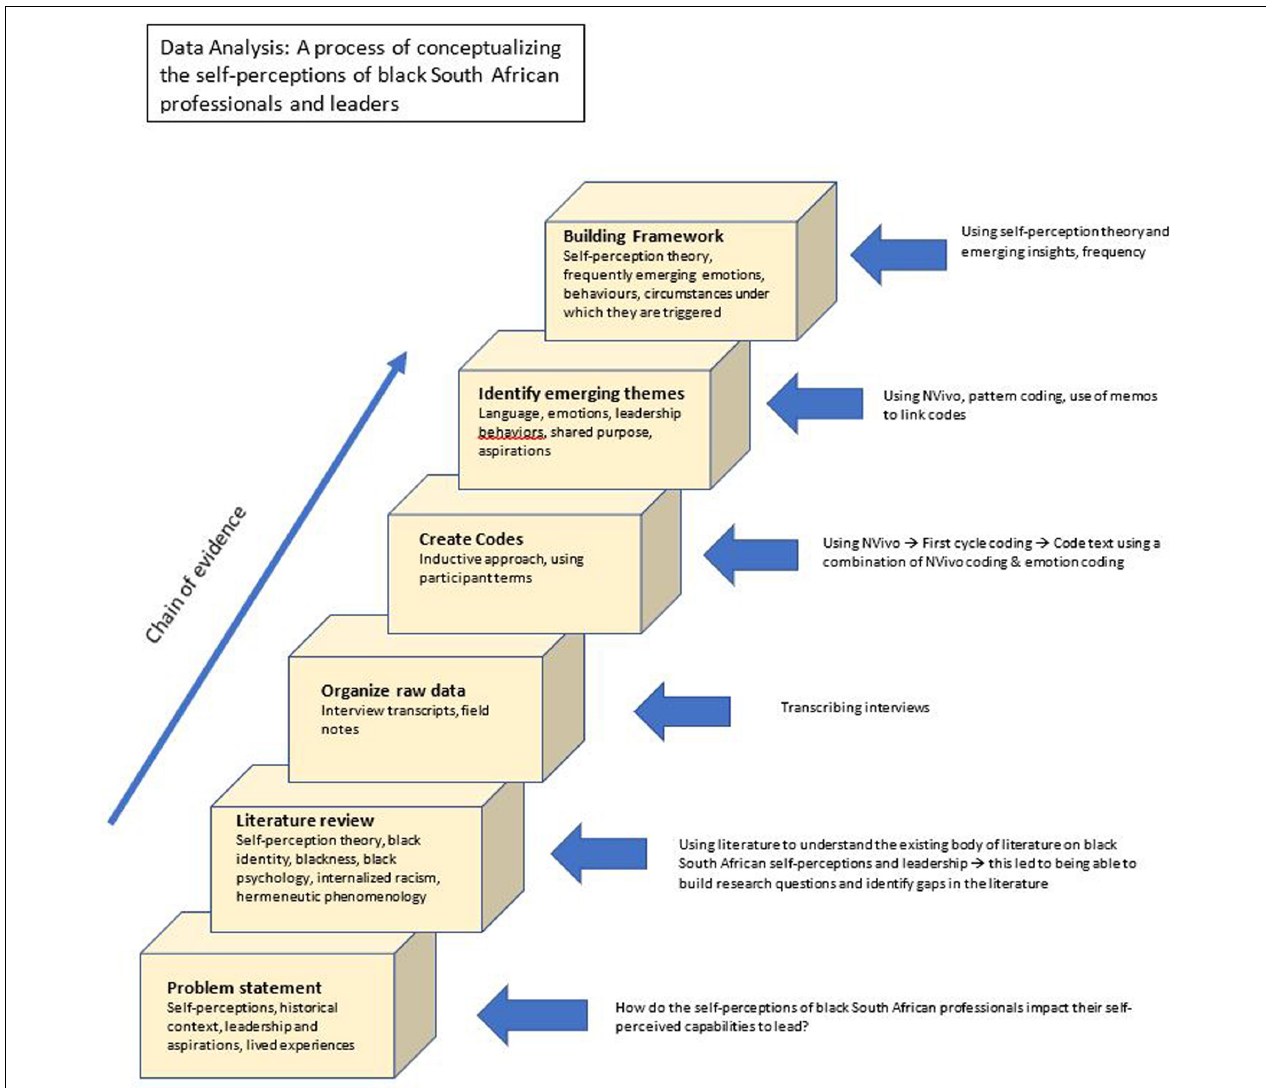
FIGURE 1 | A demonstration of the data analysis approach employed in this